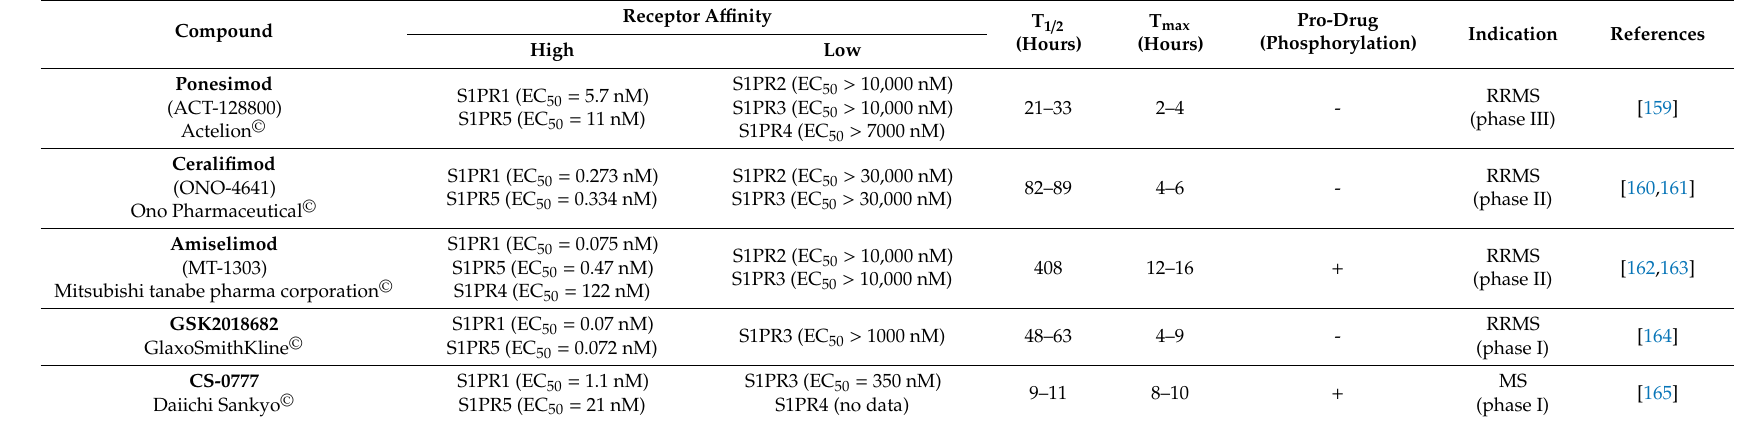
Table 3. Sphingosine-1-phosphate receptor (S1PR) modulators in ongoing clinical trials for multiple sclerosis (MS) treatment. Features: receptor a ffi nity, half-life (t1 / 2), time to reach the highest plasma concentration (Tmax), required phosphorylation, and indication for multiple sclerosis (MS) treatment (relapsing-remitting MS